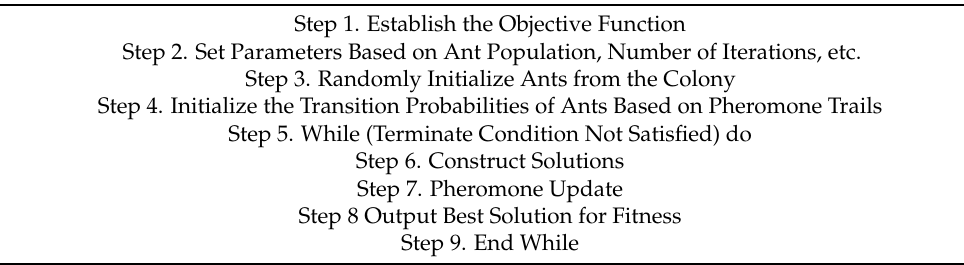
Table 2. Ant-Based Optimization Algorithm (General Pseudo Code) [11]. Step 1. Establish the Objective